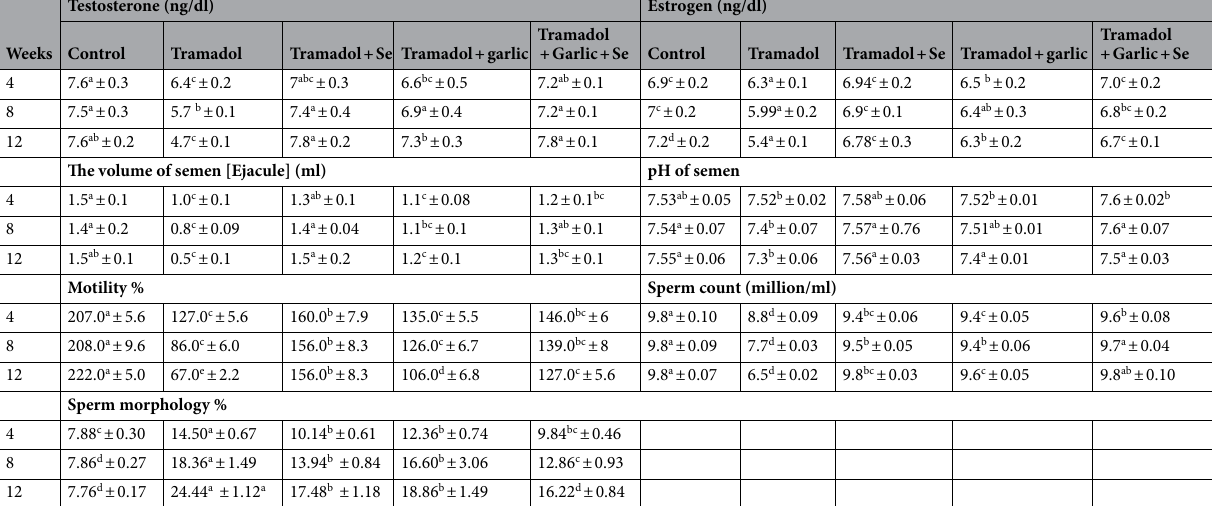
used for calculation of TBARS levels.